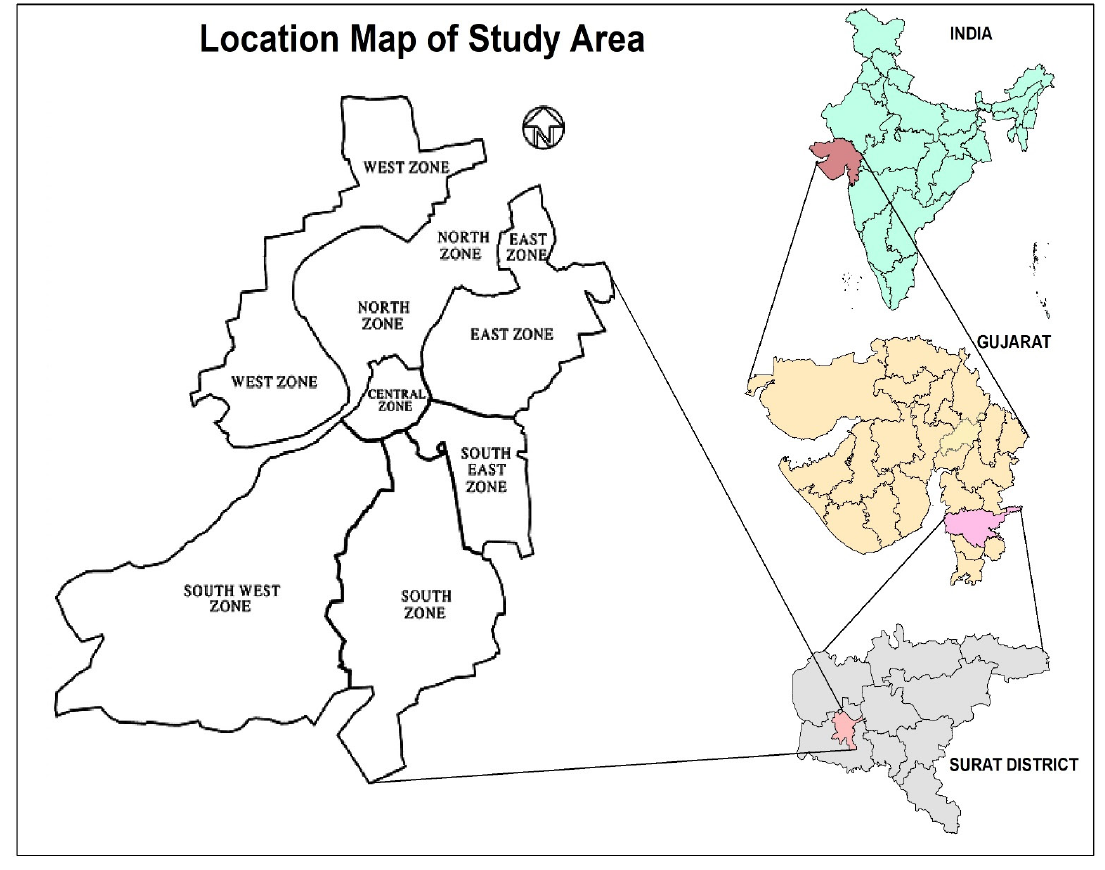
Figure 1: Study area for noise and traflc volume